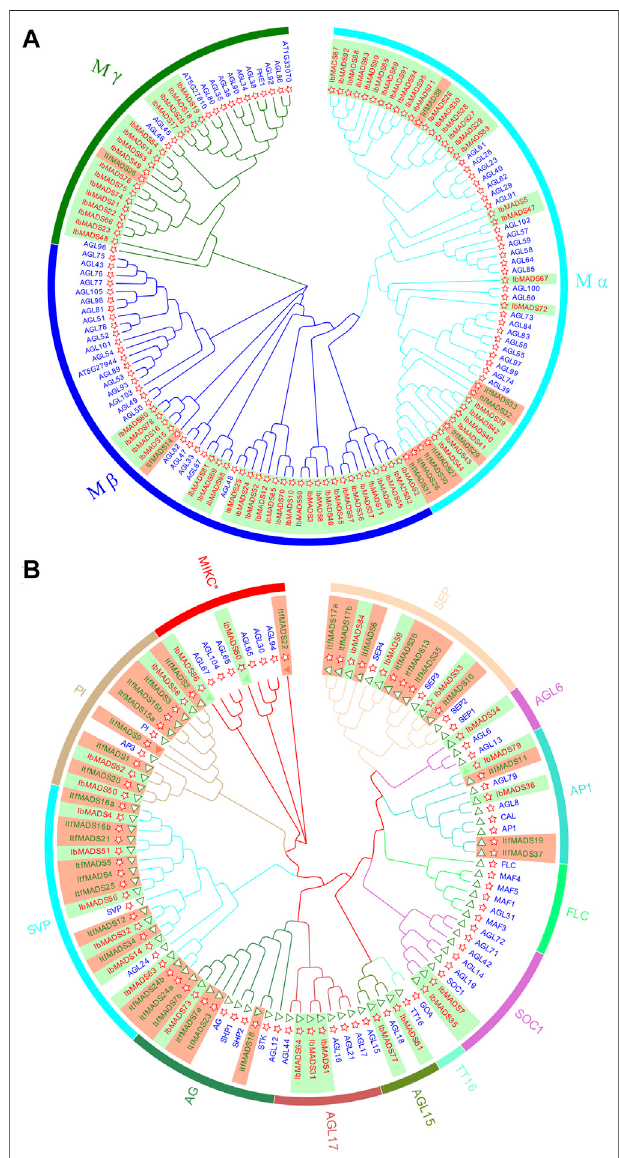
FIGURE 2 | Phylogenetic tree of type I (A) and type II (B) MADS-box proteins in Ipomoea batatas , Ipomoea tri fi da , and Arabidopsis . Red ID indicates I. batatas gene, green ID indicates I. tri fi da gene, and blue ID indicates Arabidopsis gene. The red star indicates the sequence containing the SRF-box domain, and the green triangle indicates the sequence containing K-Box domain.